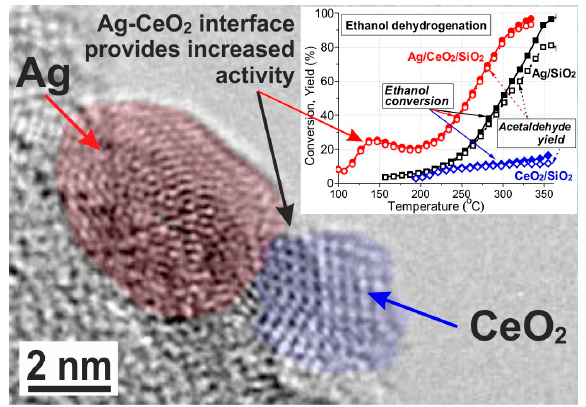
Figure 3. The contact of Ag and CeO 2 on the surface of SiO 2 and corresponding growth of activity in ethanol dehydrogenation. Reprinted with permission from reference [63]. Copyright 2018 Elsevier.